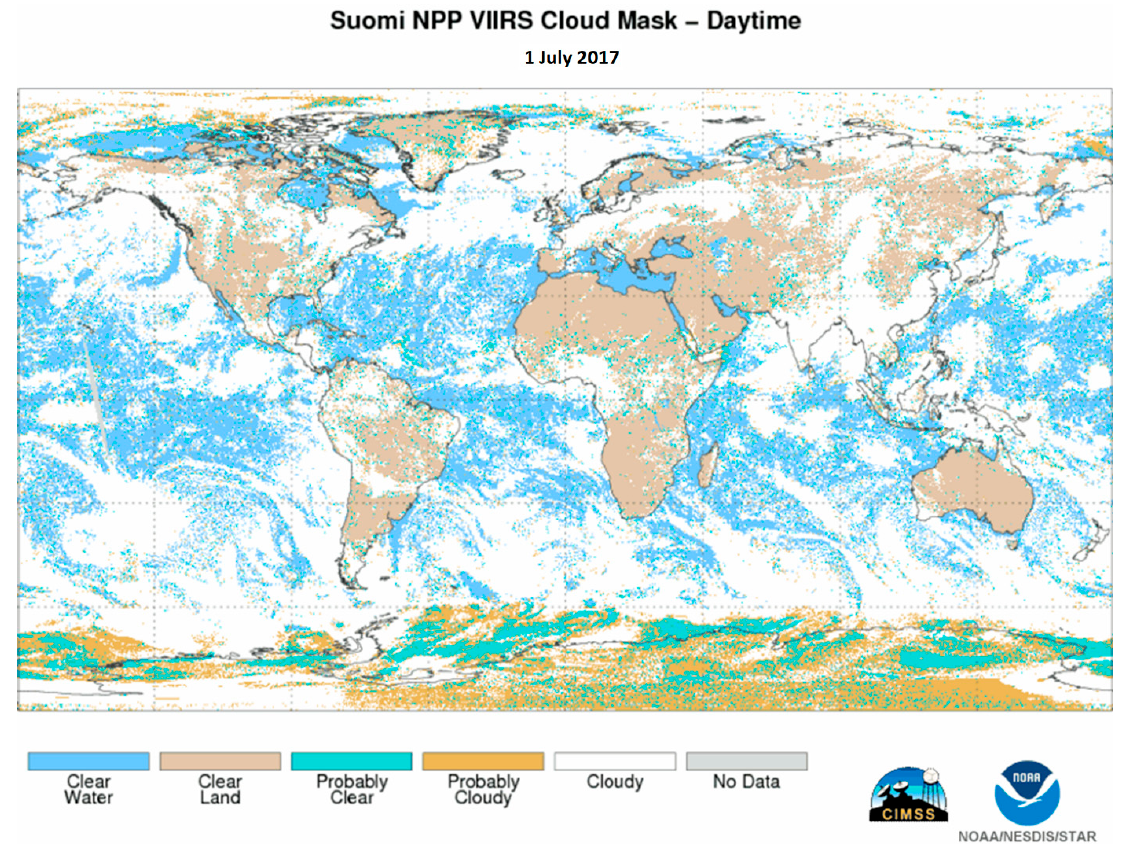
Figure 3. An example of VIIRS daytime cloud mask generated using the VIIRS enterprise cloud algorithm (Figure Courtesy: Andy Heidinger, NOAA). Table 2. S-NPP VIIRS cloud mask performance versus specifications *.